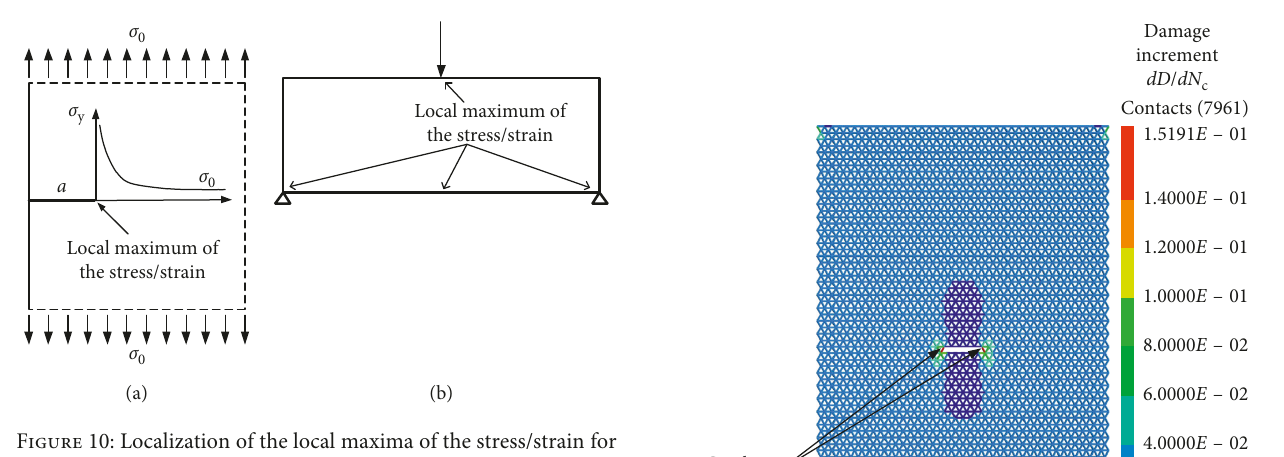
Figure 10: Localization of the local maxima of the stress/strain for (a) a cracked plate and (b) a simply supported beam.